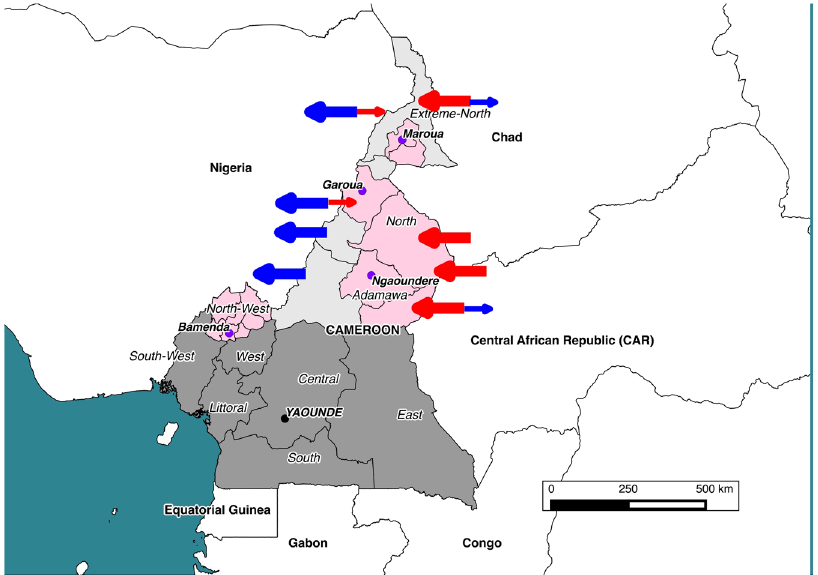
Figure 1. Map showing the location of the 4 municipal abattoirs (purple circles) in the 4 administrative Regions of Cameroon sampled between 2012–1013. The catchments supplying cattle to the abattoirs based on the butchers reporting are also shown (pink shading). Blue arrows indicate general movements out of the country and red arrows movements into Cameroon. The size of these arrows reflects anecdotal views on volumes of animals moved. The figure was generated using QGIS 2.2 (www.qgis.org) and shp files obtained from the GADM database of Global Administrative Areas (www.gadm.org).